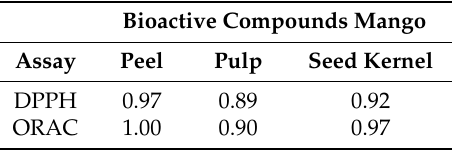
Table 6. Pearson’s correlation coefficients ( r ) between bioactive compounds (isoprenoids polyphenols and) in mango organs (peels, pulps and seed kernels) and its antioxidant capacity (DPPH and